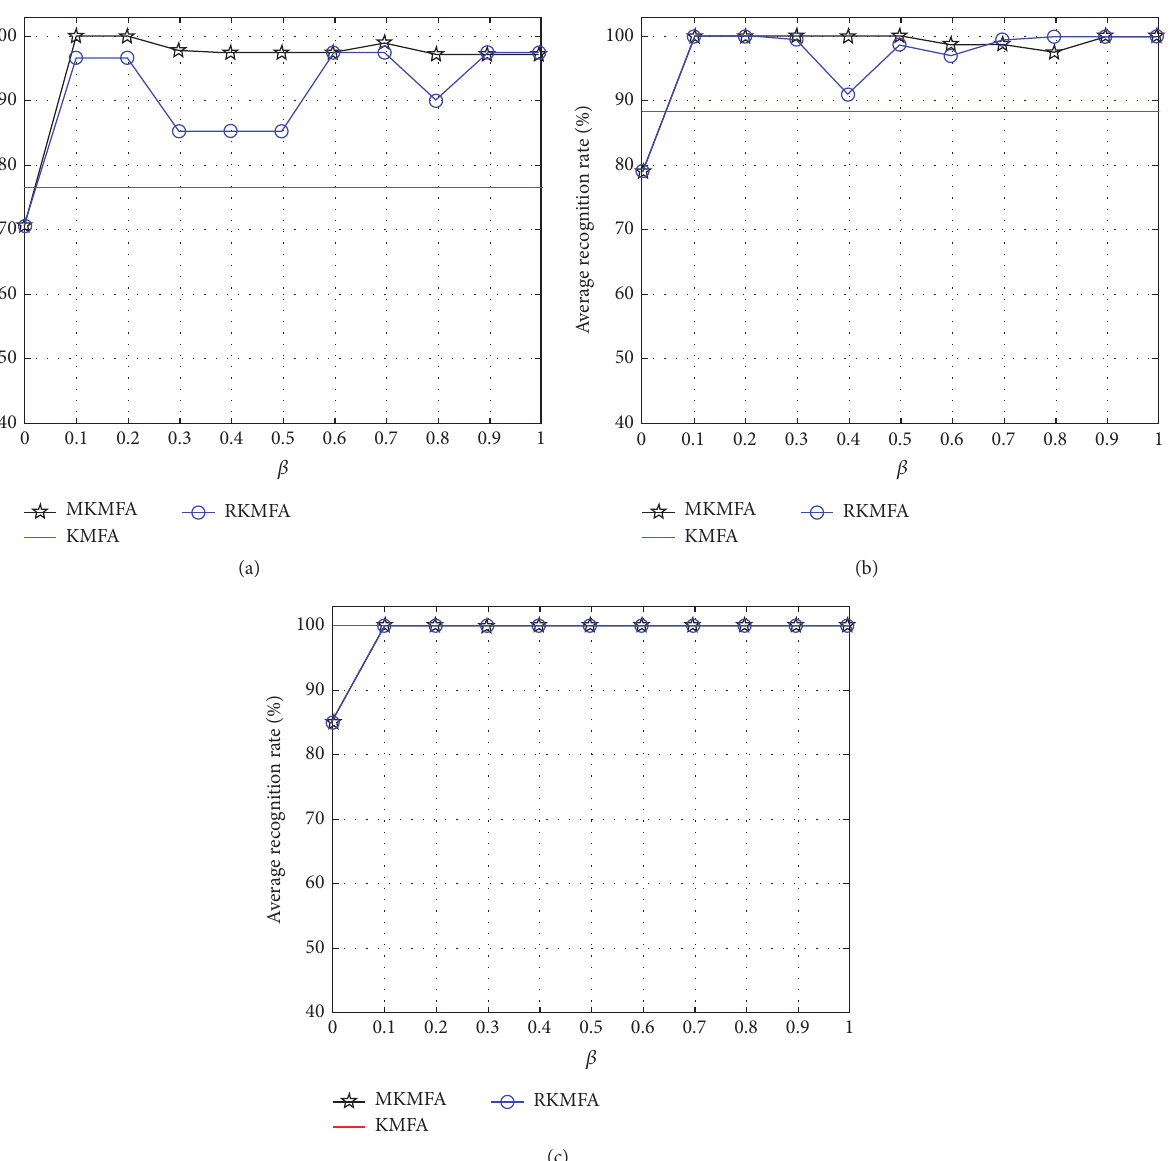
Figure 12: The average recognition rate as the training sample sizes are (a) 10, (b) 50, and (c) 90.